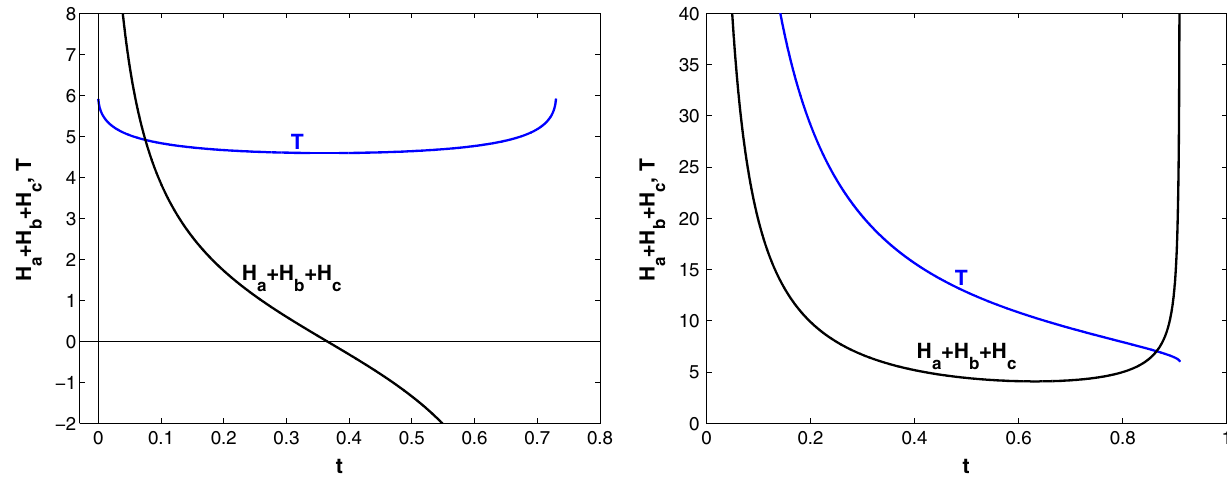
Fig. 4 The evolution of the torsion scalar T and sum of Hubble param- the left graph and H a ( 0 ) = 17630, H b ( 0 ) = 2670, H c ( 0 ) = − 2320 for eters X = H a + H b + H c for N = 2, f 0 = − 1 the right picture. The left plot displays the cosmological scenario IIb , w = 0, K = 1. The 12 and the right one shows the scenario IIc initial values are H a ( 0 ) = 157, H b ( 0 ) = 29 . 43, H c ( 0 ) = − 24 . 8 for